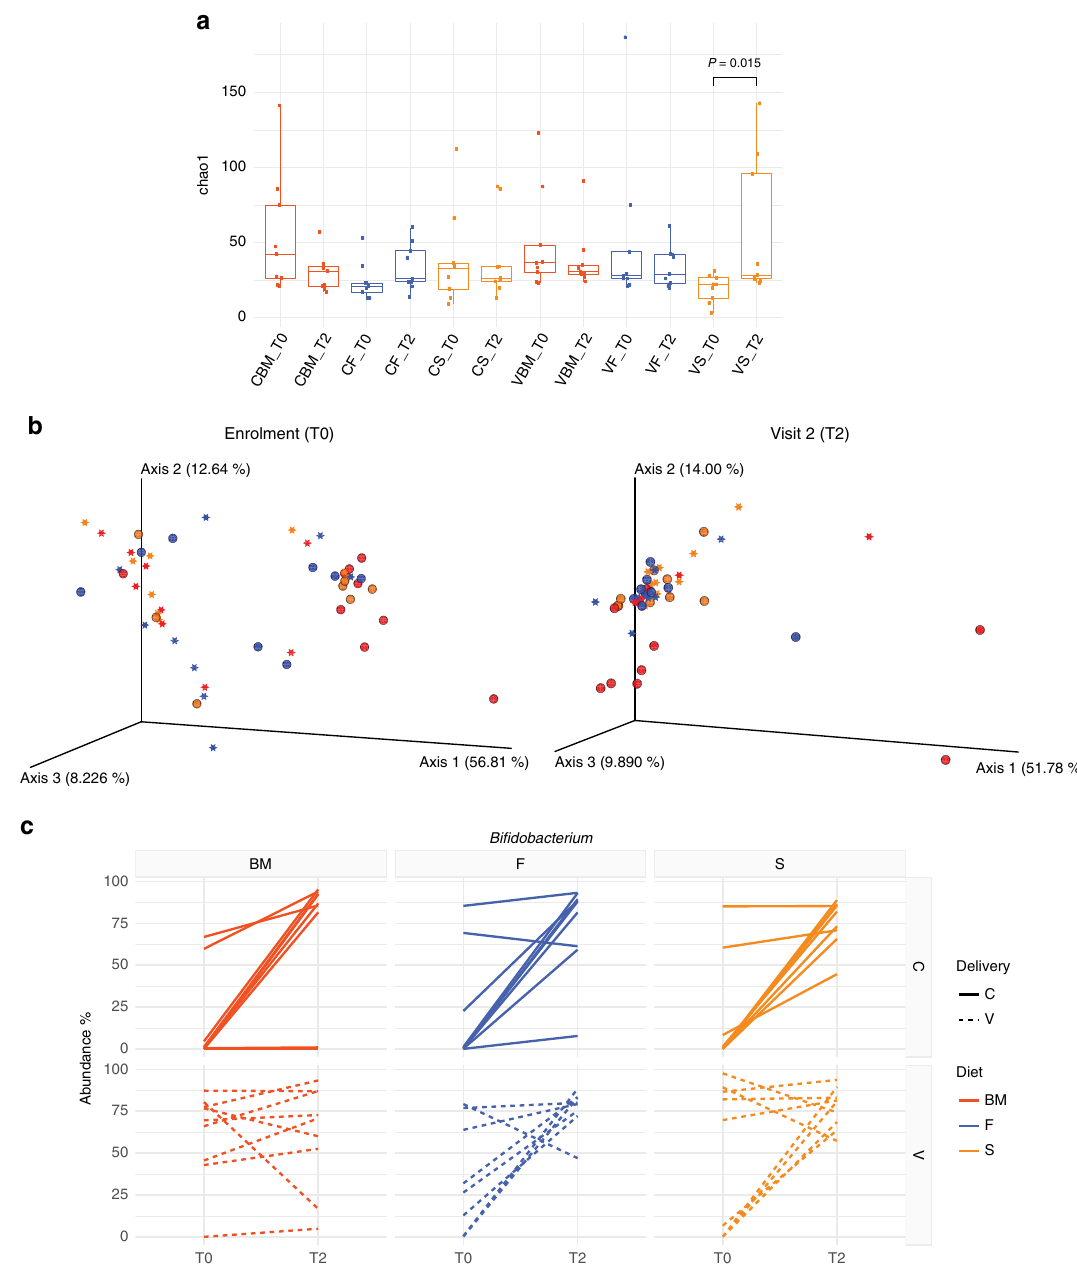
Fig. 3 Fermented formula but not standard formula reduces microbiota diversity over time. a Chao1 index of bacterial α -diversity of the faecal microbiota of infants at enrolment (T0) and visit 2 (T2). Signi fi cance determined by Wilcoxon signed-rank test for repeated measurements (two-tailed). Box plots show the interquartile range (IQR), the horizontal lines show the median values and the whiskers extend from the hinge no further than 1.5*IQR. CBM: caesarean delivery breast milk feeding, CF caesarean delivery fermented formula feeding, CS caesarean delivery standard formula feeding, VBM vaginal- delivery breast milk feeding, VF vaginal-delivery fermented formula feeding, VS vaginal-delivery standard formula feeding. b PCoA analysis of weighted UniFrac distance ( β -diversity) of gut microbial communities according to the mode of delivery (caesarean — star; vaginal — sphere) and the type of feeding (BM — red; F — blue; S — orange). Left, enrolment; right, visit 2. c Interaction plots of Bi fi dobacterium abundance according to diets and delivery mode at T0 and T2. Each line represents individual newborns (solid lines caesarean delivery, C; dotted lines vaginal delivery, V). Signi fi cance determined accounting for individual baselines with a linear mixed model and ANOVA to test the interaction between groups and time, P = 0.011. BM breast milk feeding, F fermented formula feeding, S standard formula feeding. Source data of panels a and c are provided as a Source Data fi different clusters. One (box 1) included metabolites rich in the groups were ascribable to correlations between microbial genera faeces of the reference group and sometimes of the fermented and metabolites. We limited this analysis to T2 and to the formula-fed group. These metabolites correlated with a set of metabolites found to be statistically signi fi cantly different in the genera, including Clostridiaceae, Subdoligranulum , Butyr- population as a whole (by ANOVA, Table 5 or Partial Least icicoccus , Ruminococcaceae UCG 014, Faecalibacterium , Eubac- Squares Discriminant Analysis — PLS-DA, Fig. 4b). As shown in terium Bacillus , Fig. 5, the fi rst striking observation is that we detected four